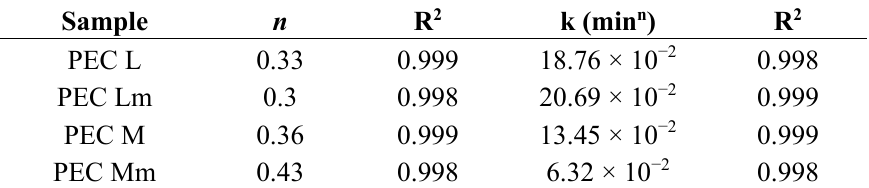
Table 2. Swelling kinetic parameters of PEC